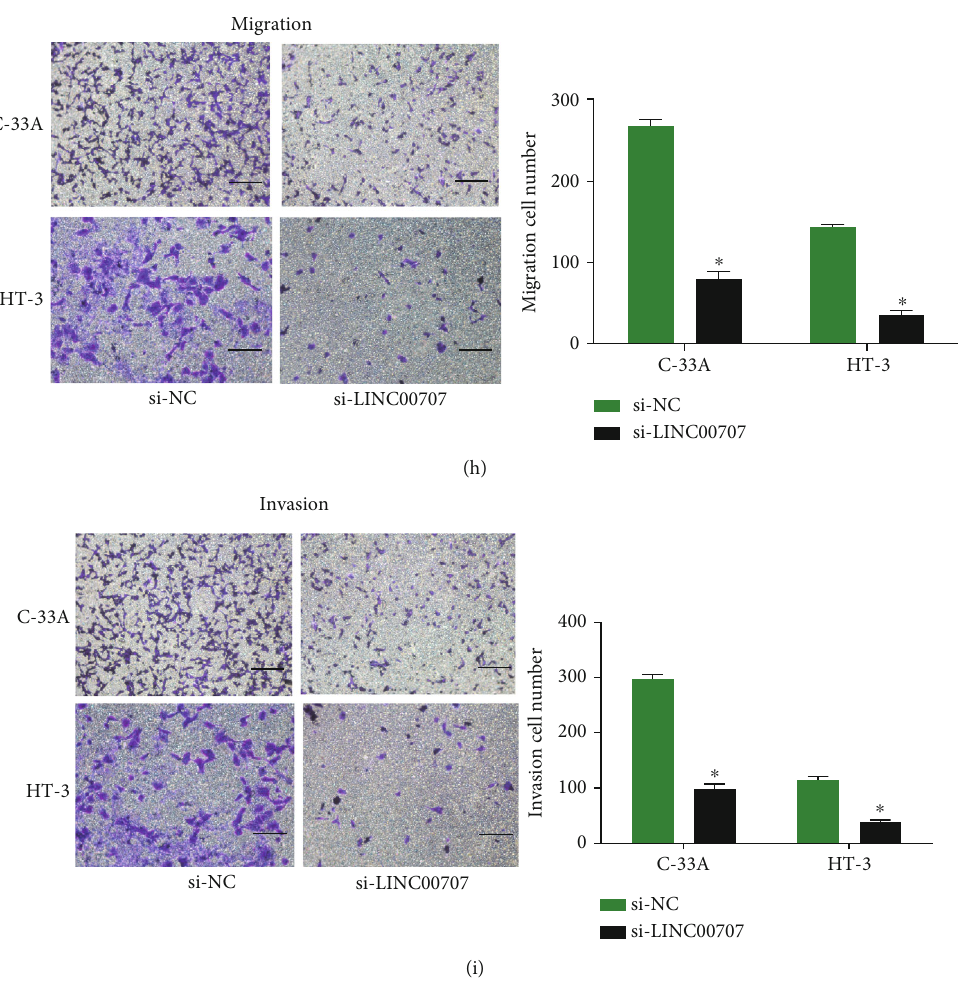
Figure 1: LINC00707 was increased in cervical cancer. (a) RT-PCR indicated the LINC00707 expression in cervical cancer tissues ( n = 20 ) and adjacent normal tissues ( n = 20 ). (b) LINC00707 expression in cervical cancer cells (HT-3, HCC94, CaSki, C-33A, MS751, and normal cervical cell HEKn cells). (c, d) The expression level of LINC00707 in C-33A and HT-3 cells was tested by RT-PCR. (e, f) Cell proliferation was tested after transfection with LINC00707 siRNA using CCK-8 assay. (g) Cell apoptosis was evaluated using TUNEL assay ( scale bar = 50 μ m). (h, i) Transwell migration and invasion assay were performed. ∗ P < 0 : 05 and ∗∗∗ P < 0 : 001